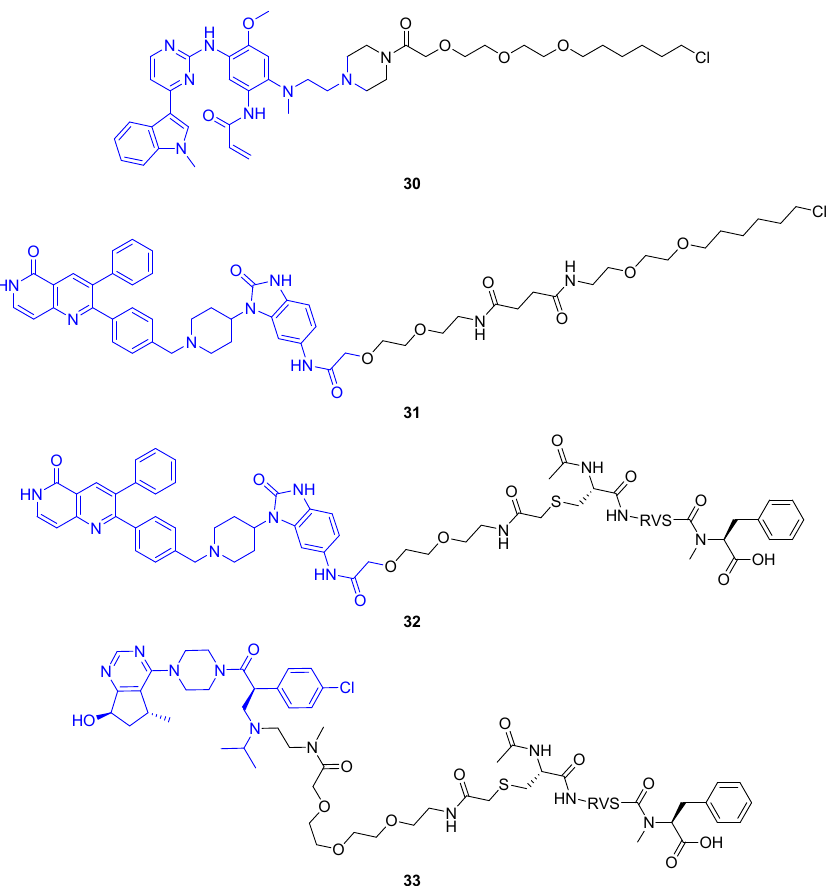
Figure 17. Dephosphorylation-targeting heterobifunctional molecules from Yamazoe et al. [62]. Initial compounds based on HaloTag-reactive groups induced dephosphorylation of EGFR ( 30 ) and AKT ( 31 ) fusion proteins. Additionally, PhoRCs 32 and 33 were developed to remove phosphate from pAKT in native cell lines. While 32 incorporates an allosteric AKT binder, 33 comprises an ATP-competitive ligand.